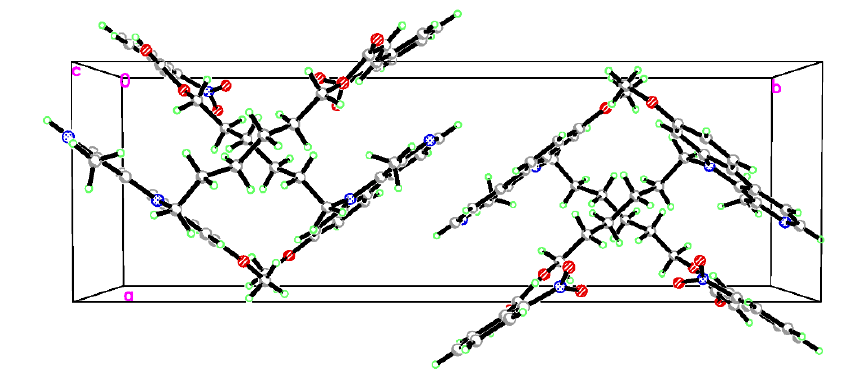
Figure 4. Stacking diagram of compound 7l .